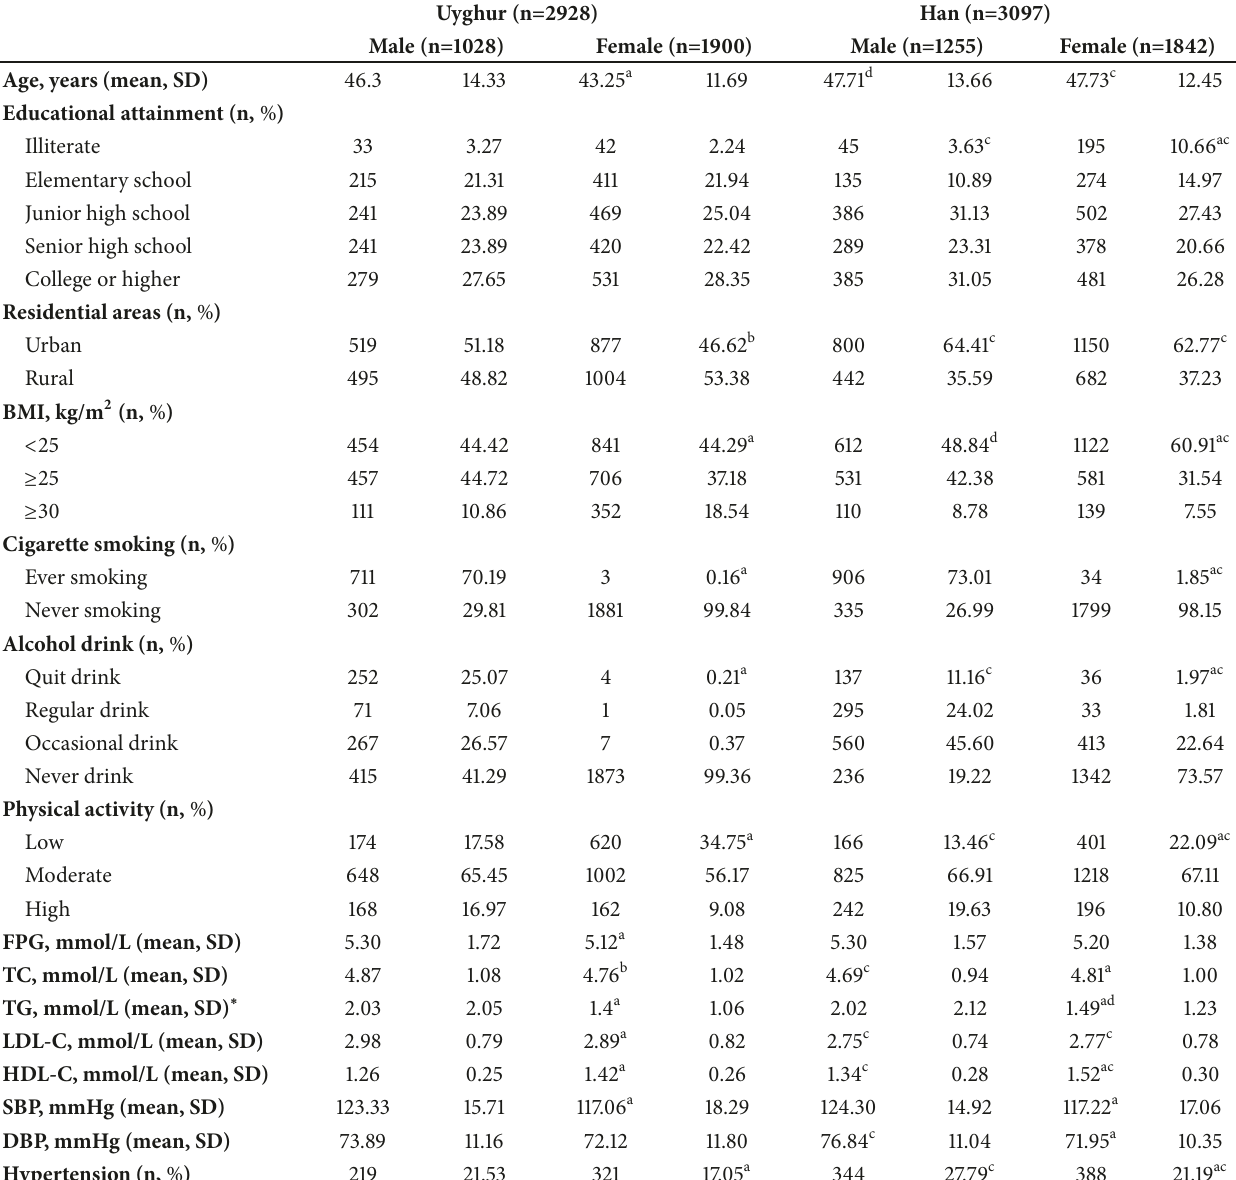
Table 1: Demographic and clinical characteristics of Uyghur and Han adults of China,